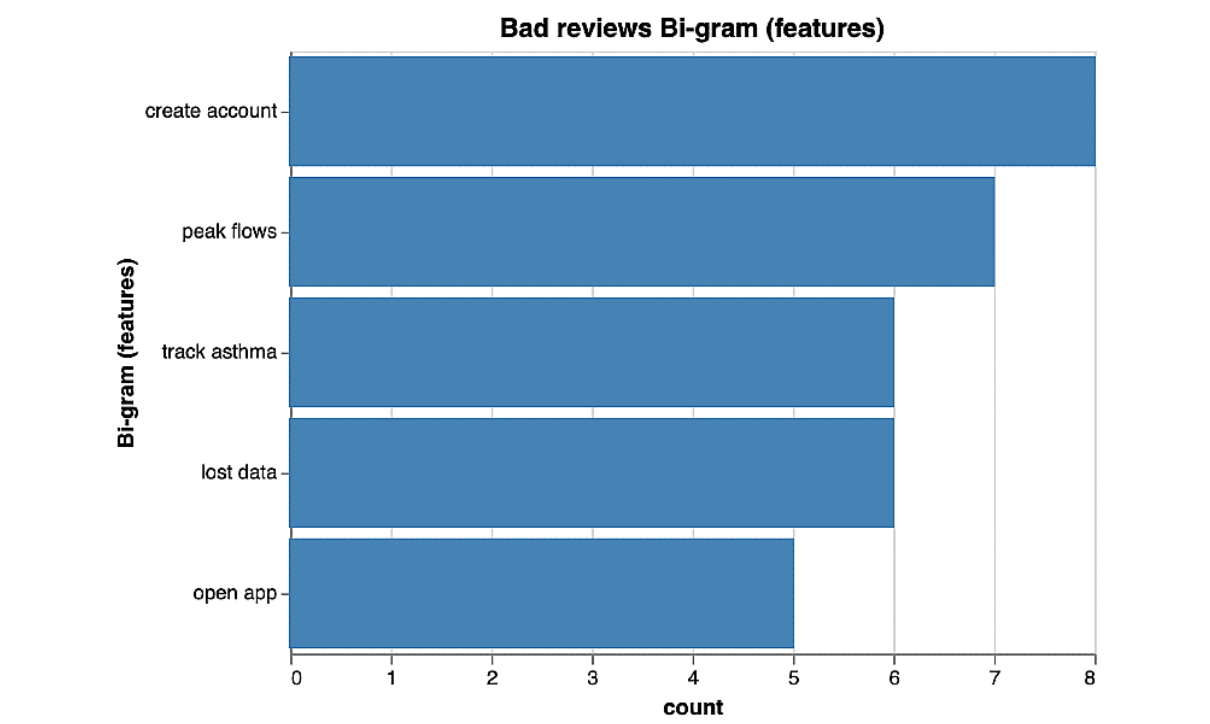
Figure 5. Bi-gram results of features of poorly rated asthma